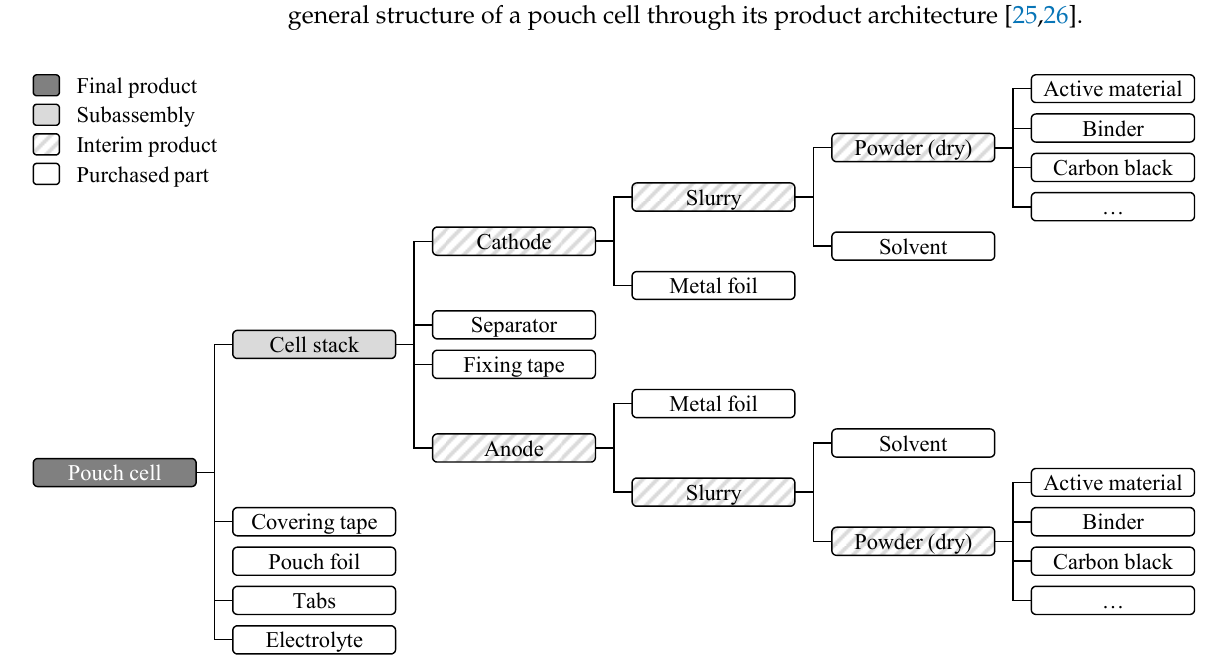
Figure 3. Product structure of a lithium-ion pouch ba tt ery cell.